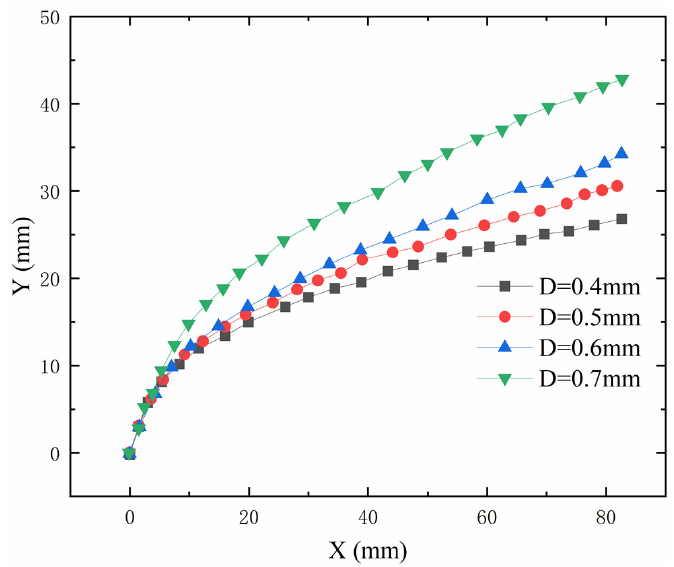
Figure 9. Comparison diagram of the jet’s external trajectory under different nozzle diameters.